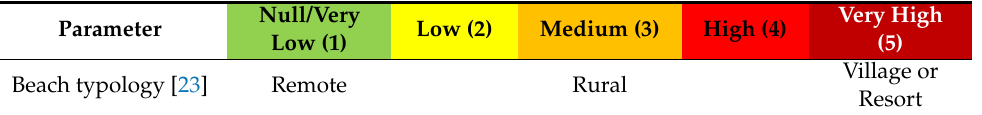
Table 8. “Beach typology”